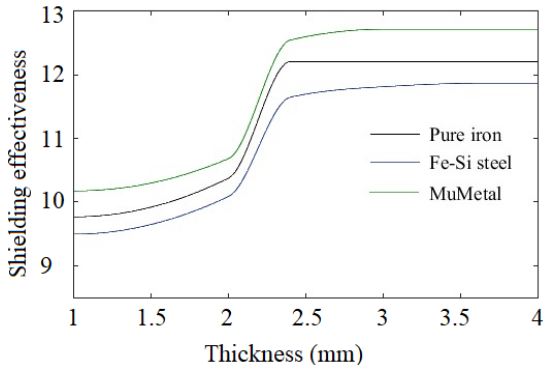
Figure 13. Shielding effectiveness with different shielding material.